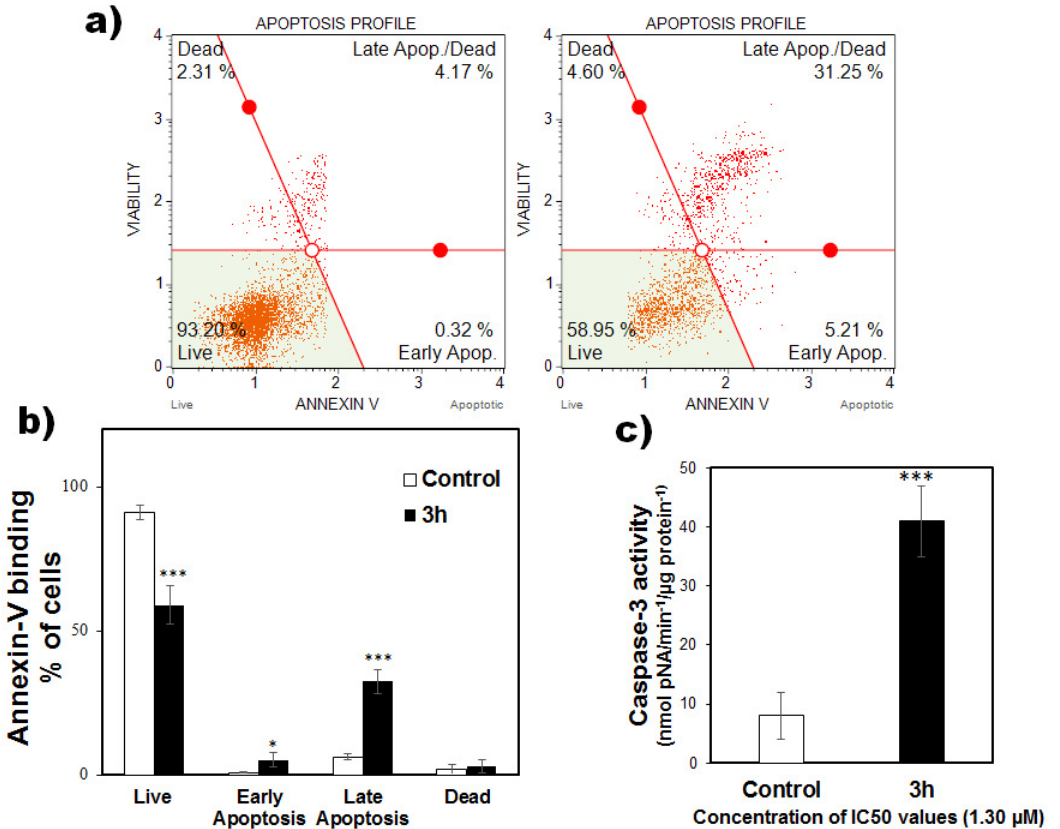
Figure 5 . Apoptosis profile for PC-3 cells treated with compound 3h (1.30 µM) a) Annexin-V binding b) The percentage of live, early and late apop- tosis/dead cells by MUSE cell analyzer c) Caspase‐3 activity (* p < 0.05, *** p < 0.001 vs